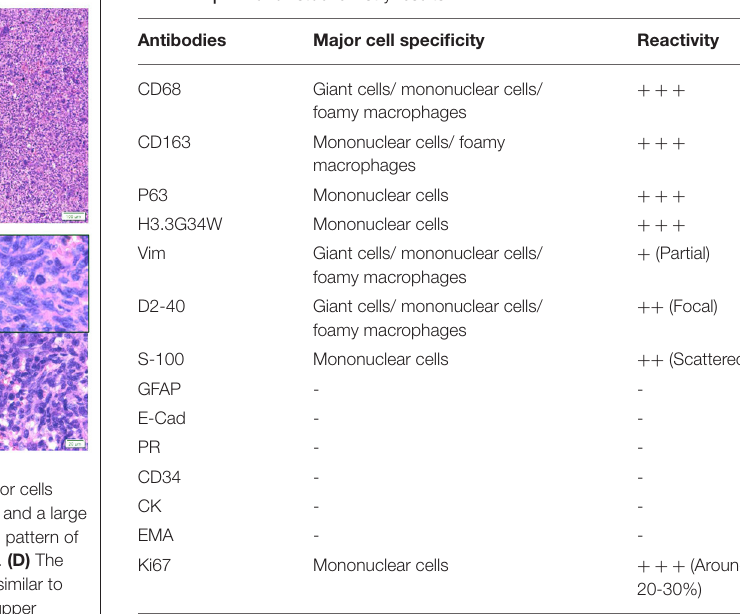
TABLE 1 | Immunohistochemistry